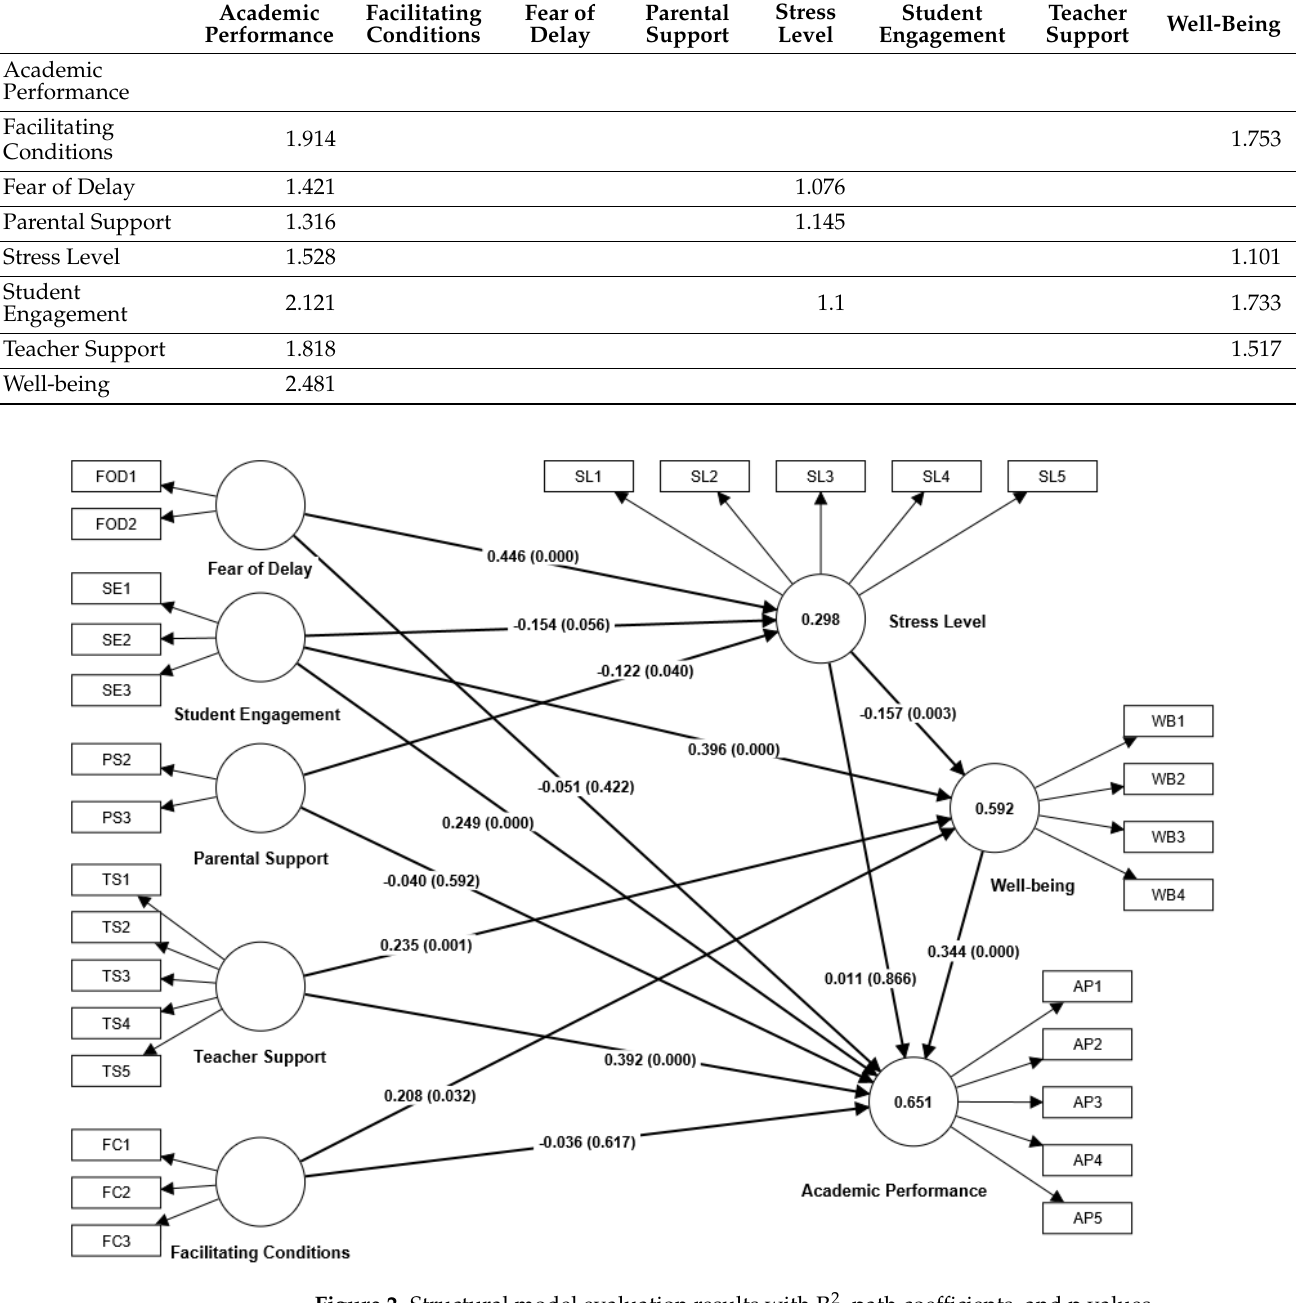
Table 7. Results of the initial hypothesis test. Relationships